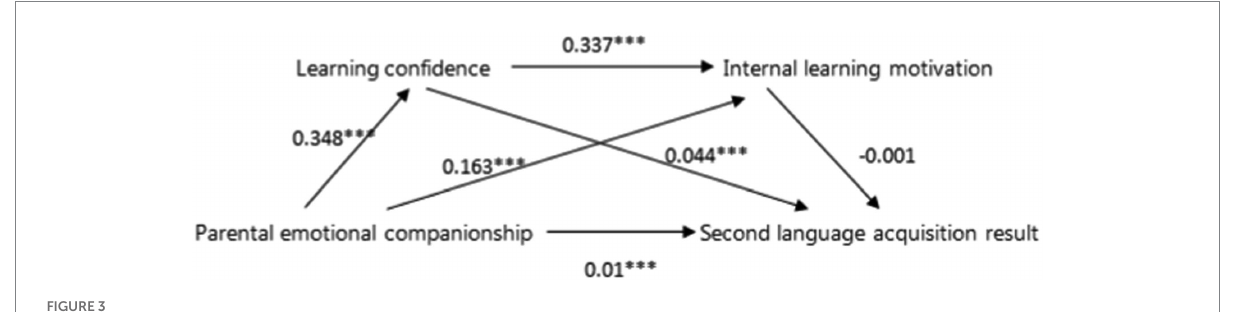
FIGURE 3 Verification result of the theoretical model of the middle school